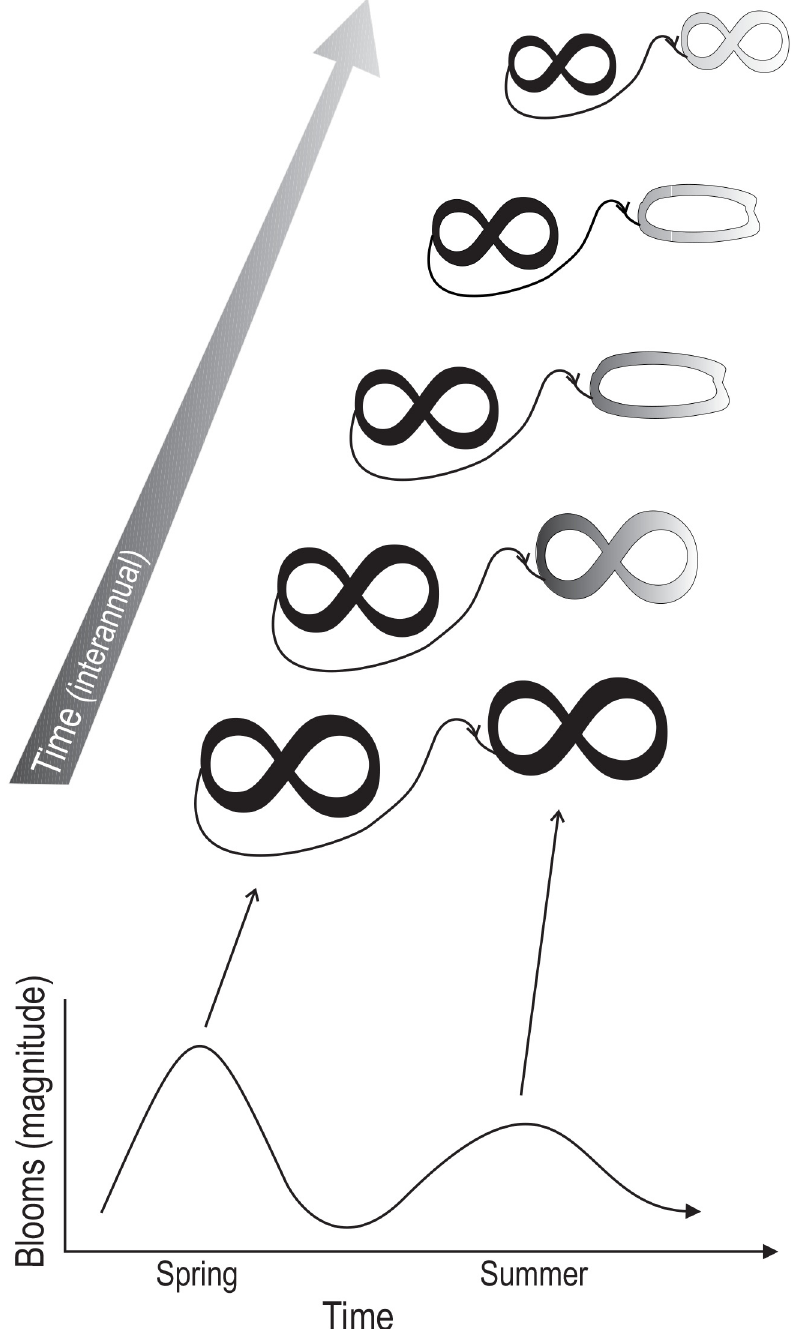
Fig 7. Conceptual figure. Summary of results of this study showing the complementarity of the traditional phytoplankton successional model (lower diagram) with adaptive cycles theory. Shown are spring and summer blooms and how they change interannually from an adaptive cycle perspective. Different shapes indicate that community changes within blooms are dynamic but these changes must not necessarily reflect adaptive cycle phases. These shapes of community change are often recurrent highlighting conservative patterns. Despite this, species contributions to these dynamics may change over time (different shades of gray), affecting spring and summer blooms distinctly, highlighting potential adaptive responses to environmental